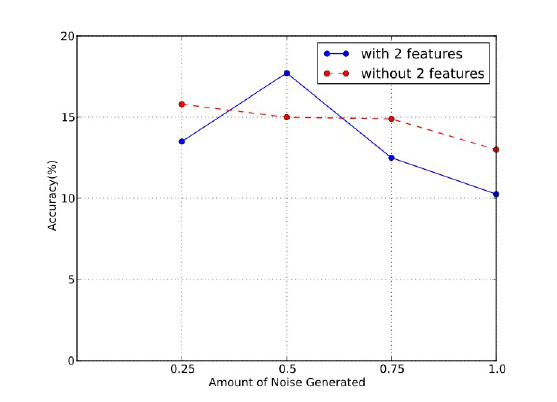
Figure 9. The accuracy using the Random Forest algorithm when considering the outgoing packet features or